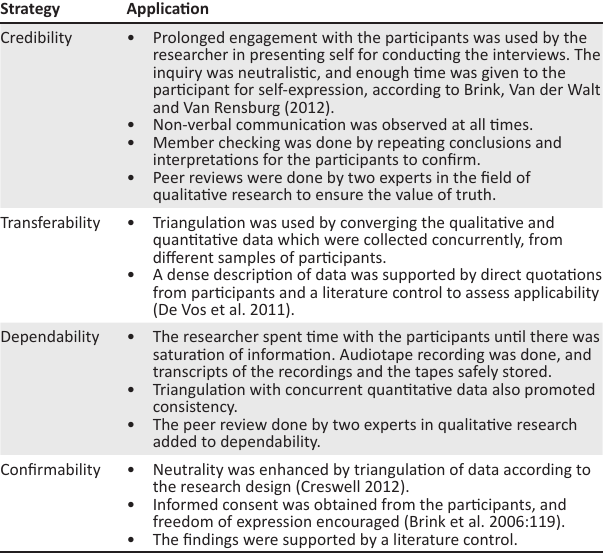
TABLE 1: Application of measures to ensure trustworthiness. Strategy Application Credibility